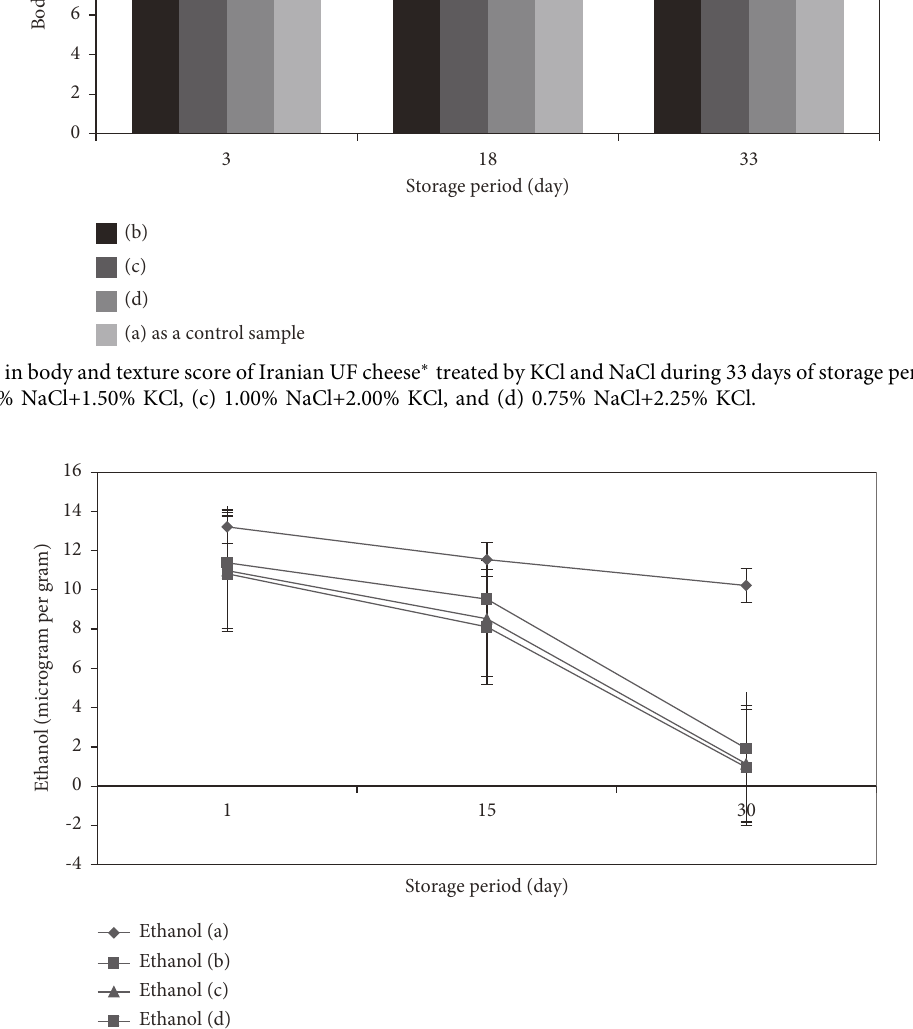
Figure 5: Changes in acetoin ∗∗ ( µ g/g) during storage of Iranian UF cheese ∗ treated by KCl and NaCl during 30 days of storage period. ∗ (a) 3% NaCl (control), (b) 1.50% NaCl+1.50% KCl. (c) 1.00% NaCl+2.00% KCl, and (d) 0.75% NaCl+2.25% KCl. ∗∗ means at the same age differed significantly ( P > 0 .